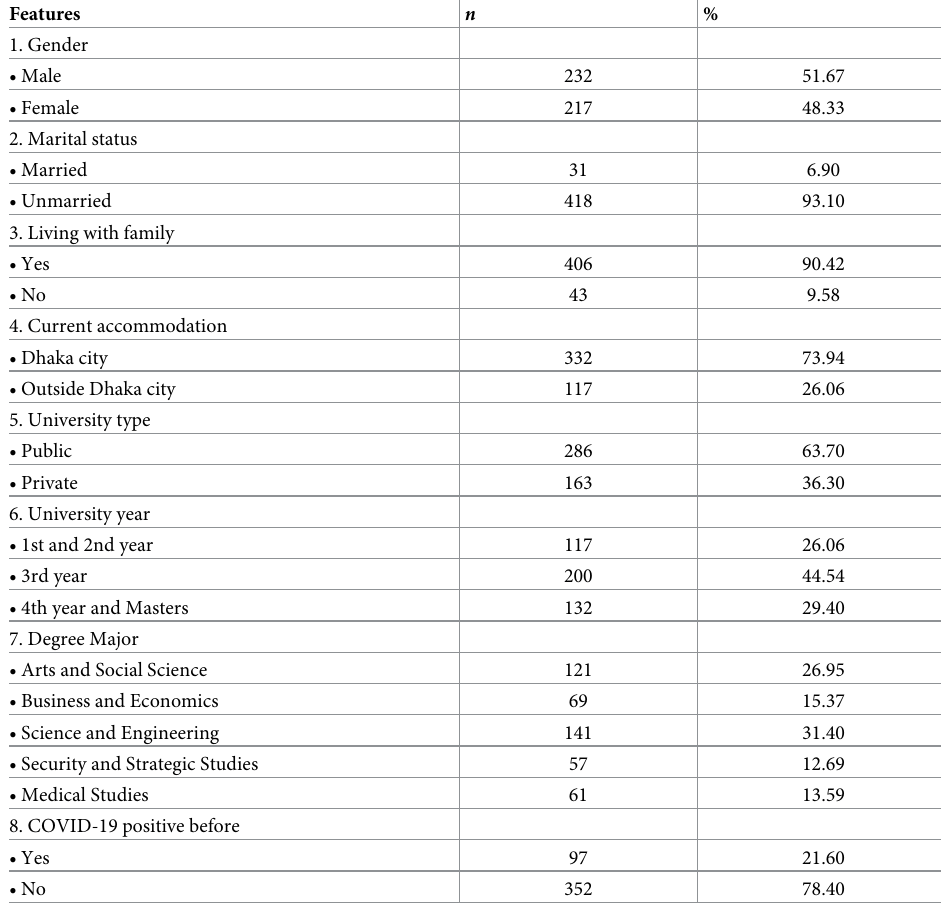
Table 1. Socio-demographic and academic information ( n = 449). Features